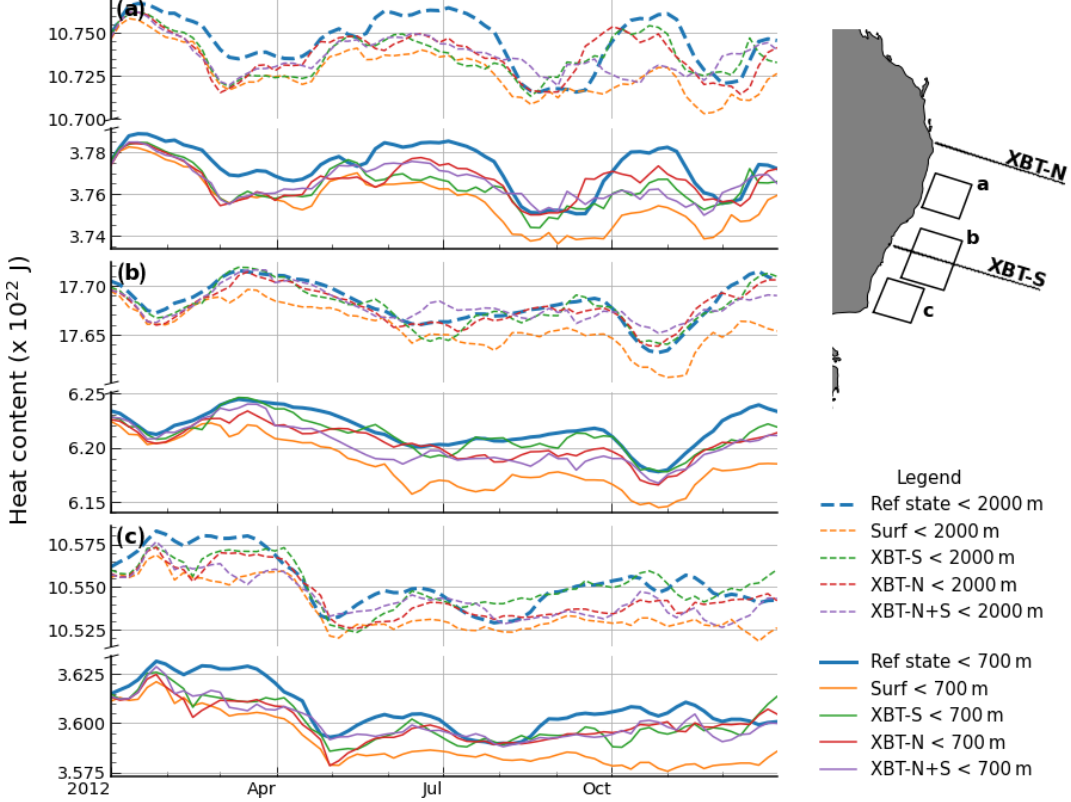
Figure 8. The temporal evolution of integrated upper ocean heat content for three key regions: (a) upstream of the EAC separation zone, (b) the high EKE variability region, and (c) the region with strong UOHC trends, with locations shown in inset. The upper 700m is shown with solid lines and the upper 2000m is shown with dashed lines. Note the broken y